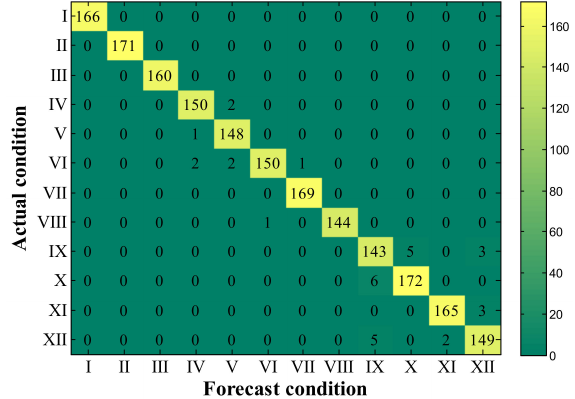
Figure 10. Confusion matrix for 1H dataset of